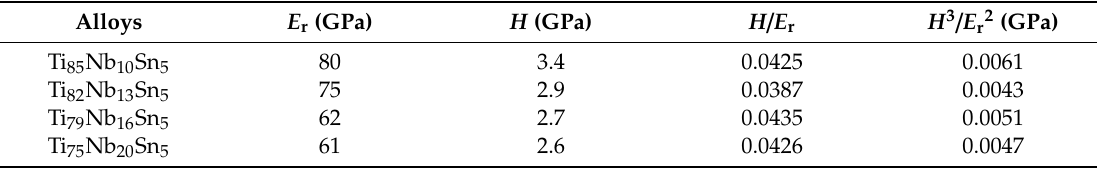
Table 3. Measured mechanical properties of Ti–Nb–Sn alloys from the nanoindentation, including hardness ( H ), reduced elastic modulus ( E r ), H / E r , and H 3 / E r2 . Alloys E r